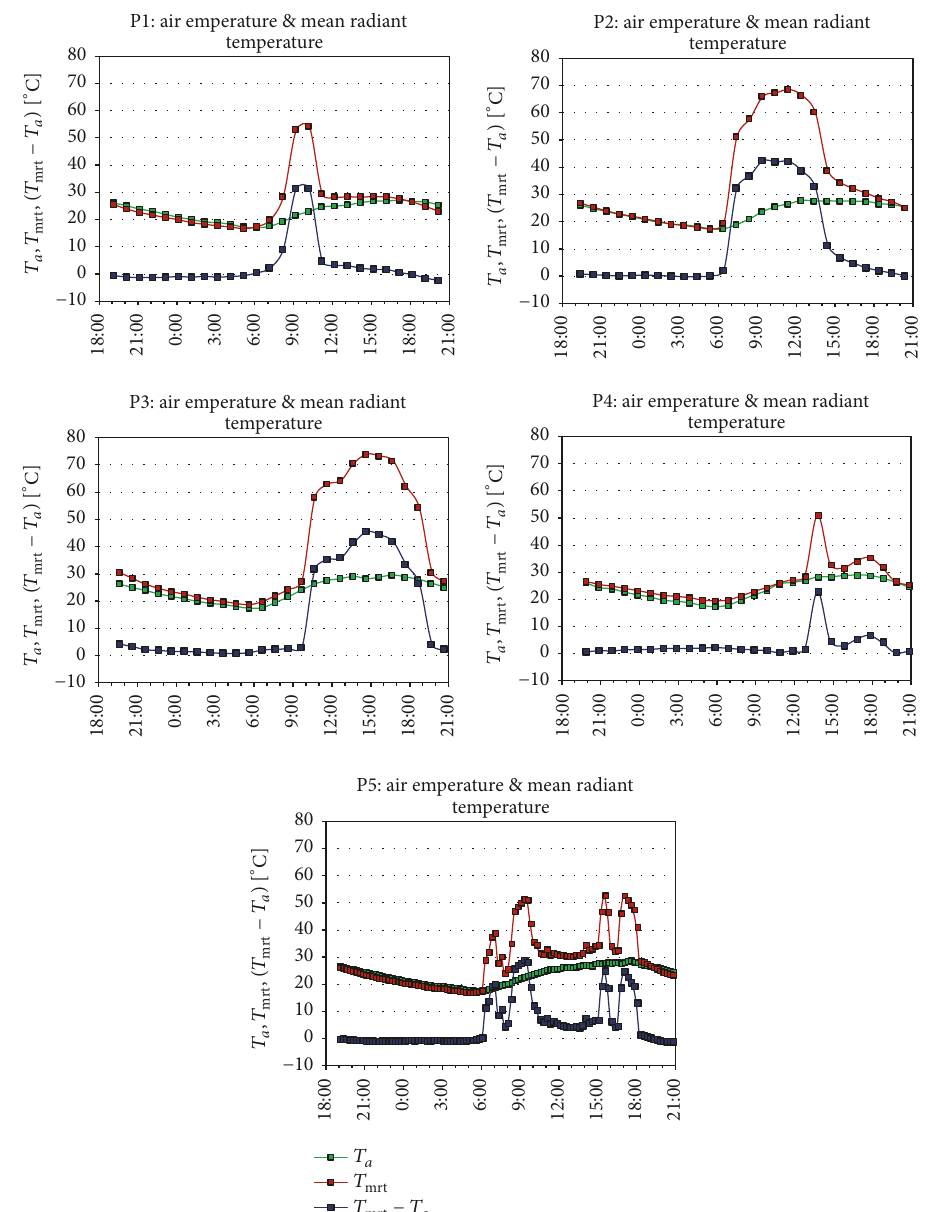
Figure 7: Air temperature ( 𝑇 𝑎 ), mean radiant temperature ( 𝑇 mrt ), and their differences at the five survey points.